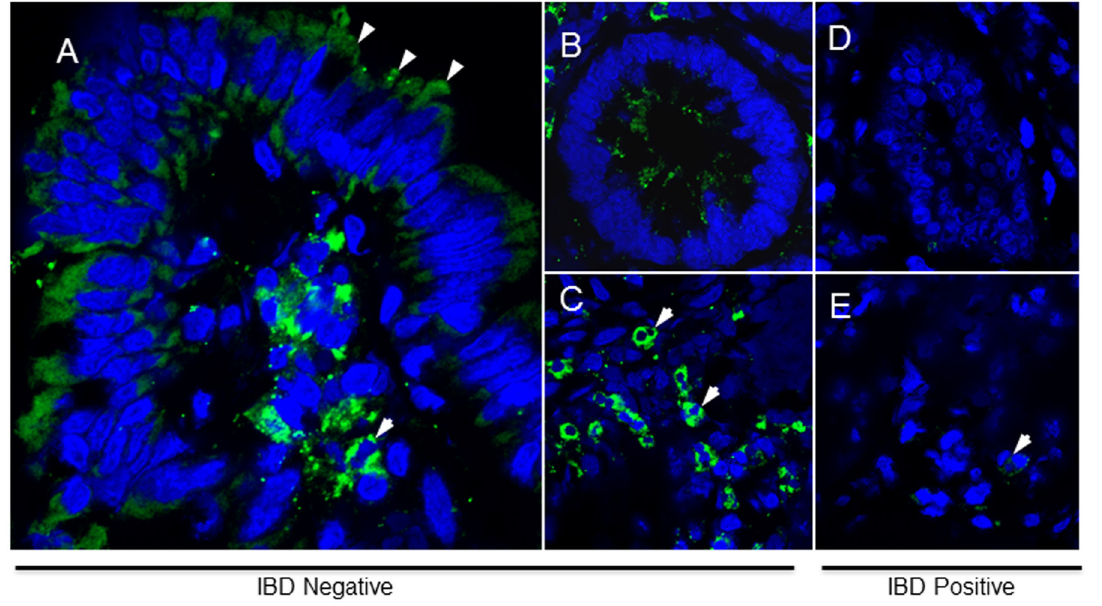
Figure 6. Decrease in ANXA1 levels in affected areas of the gut in patients with CD. Indirect immunofluorescence using a mouse anti-human ANXA1 antibody is shown with sections of colon resections from non-IBD (A-C) and IBD patients (D-E) by confocal microscopy analysis. (A) ANXA1 protein is localized in cytoplasm of the epithelial cell layer (arrowheads) and dispersed leukocytes in the mucosa in the crypt (B) and villus (C). (C) Non-IBD submucosal PMN (arrowheads) show increased levels of immunolabeling for ANXA1 in the cytoplasm in contrast to IBD patients. (D) ANXA1 protein is not detected in the crypt enterocytes and (E) weakly observed in some submucosal leukocytes (arrowhead) from IBD samples (Magnification 400×). doi: